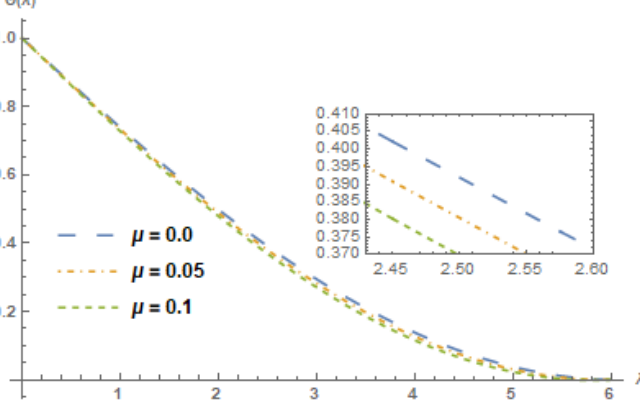
Figure 6. Temperature profile Θ ( η ) for different choices of energy absorption elements µ at M = 9, N = 0.5, P R = 6, χ = π , τ = 0.6, η u = 0.1, Γ = 2, ε = 1, C T = 0.1, S = 1 showing their 6 exciting nature.